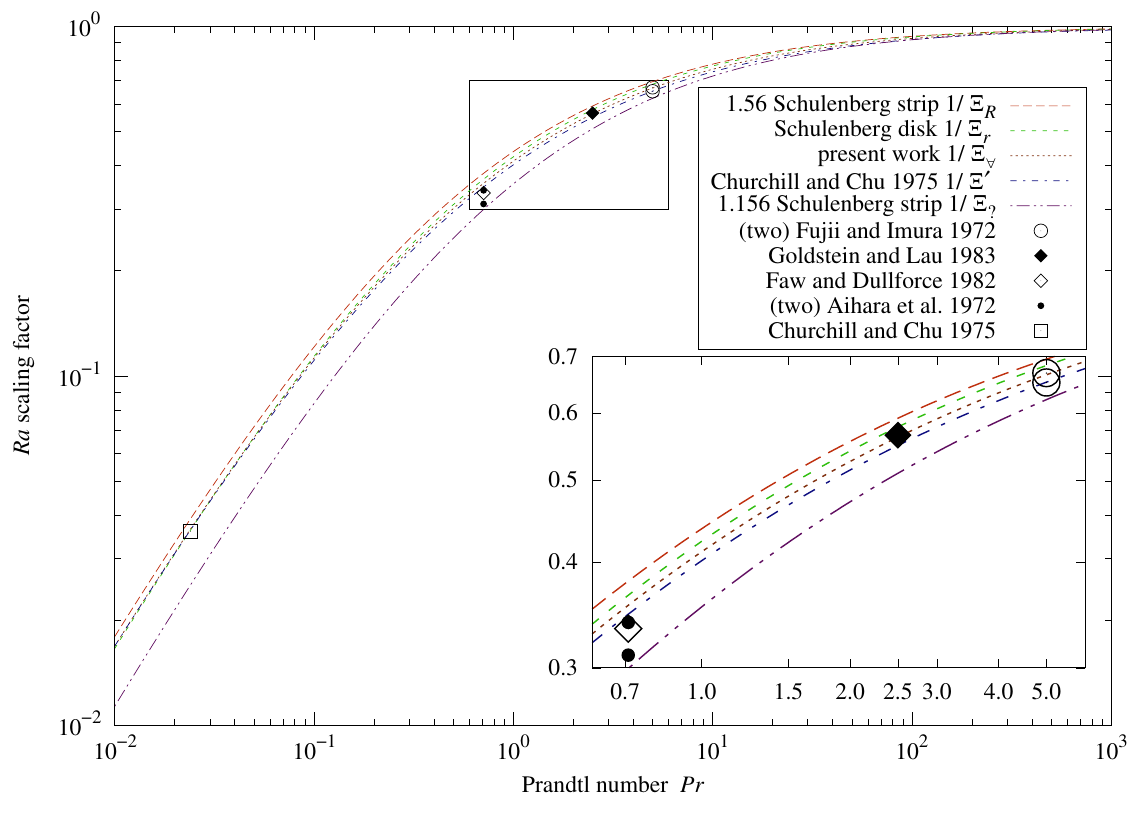
Figure 4. Ra scaling functions. Table 5. Ra scaling